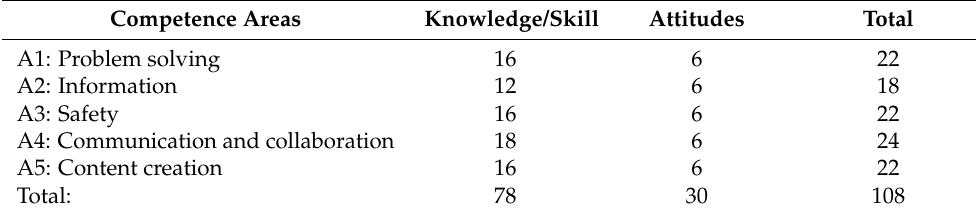
Table 4. Number of items that make up the “ECODIES”